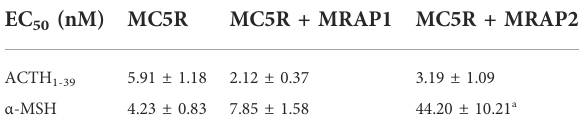
TABLE 1 EC 50 values of chicken ACTH 1-39 and α -MSH in activating cAMP/PKA signaling pathways in CHO cells expressing chicken